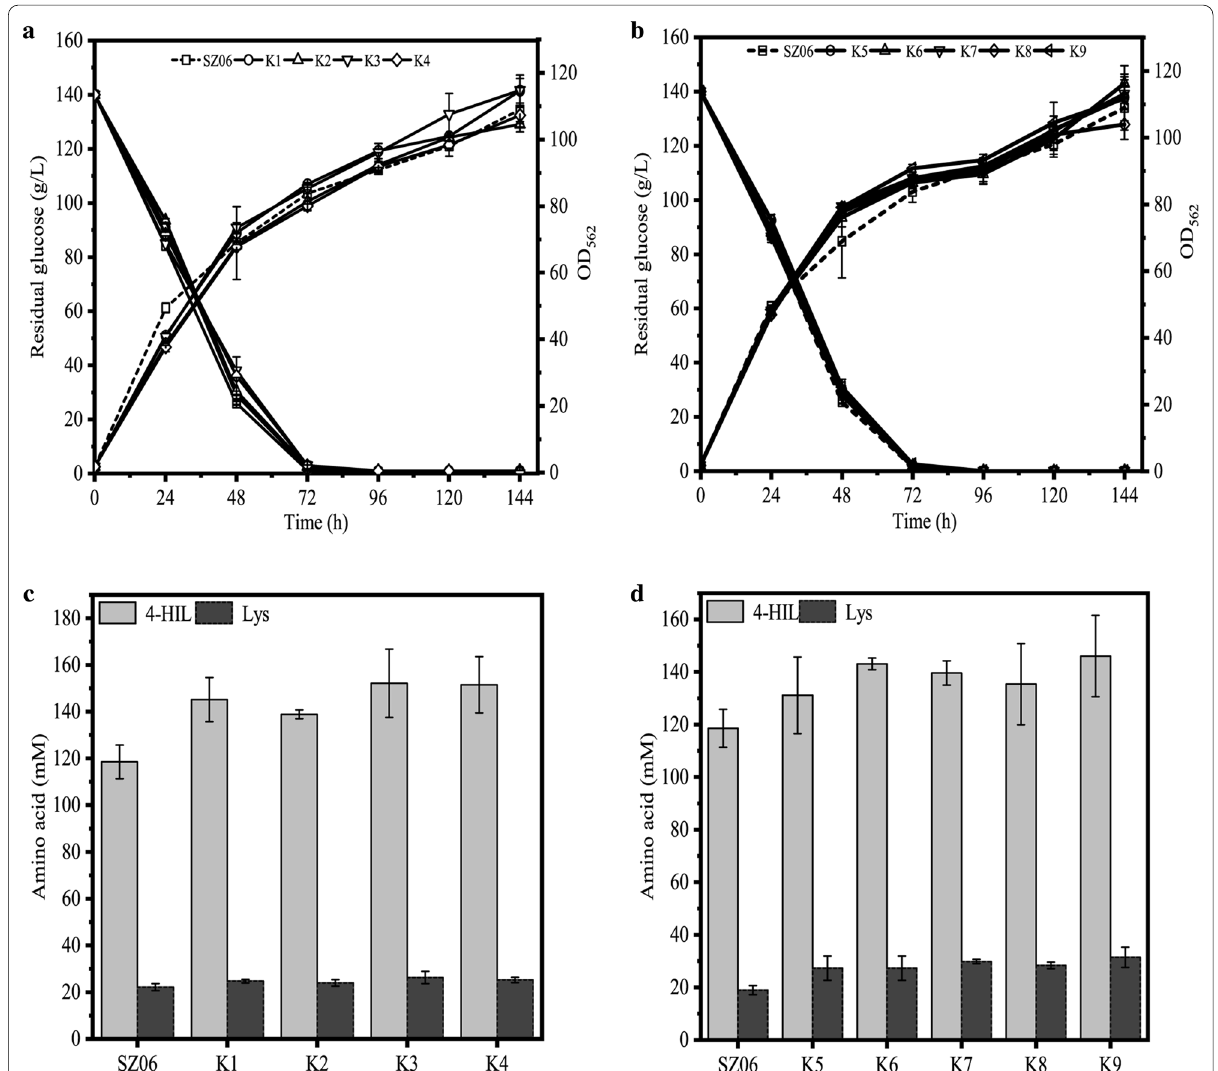
Fig. 5 The 4-HIL fermentation of mutant strains K1 consumption of K1 K4, b Cell growth and glucose consumption of K5 − concentration of K5 −